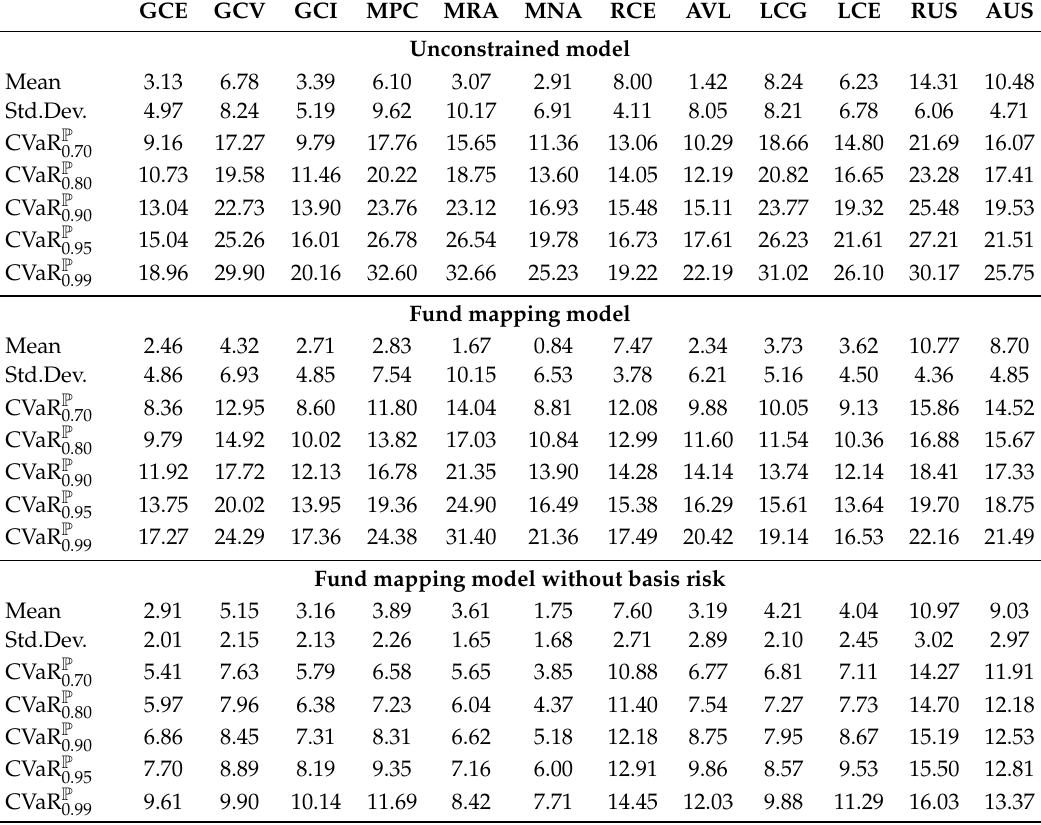
Table 7. Results for the minimal variance hedge applied under the unconstrained model (top panel), under the fund mapping constraints (middle panel), and under the fund mapping constraints with σ M = 0 (bottom panel). Funds are described in Table 1. The statistics are for the discounted sum of e − rt I t injections: ∑ T t = 1